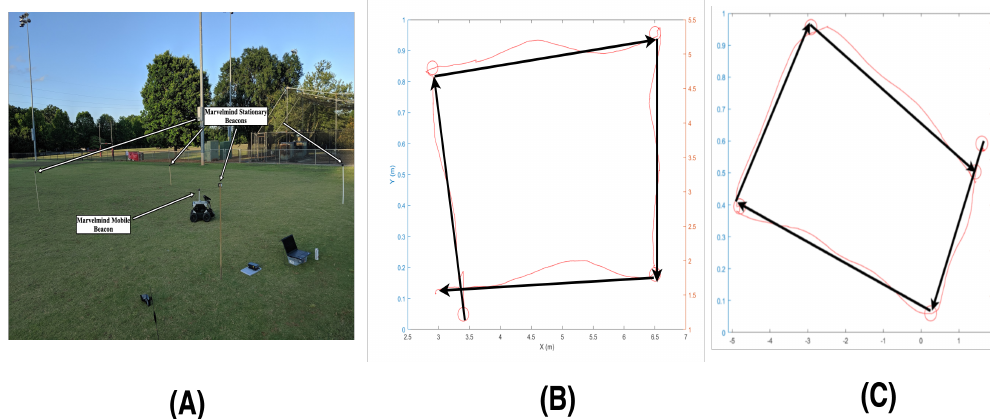
Figure 12. Navigation results. ( A ) Marvelmind based navigation setup; ( B ) Marvemind beacon navigation result; ( C ) RTK Novatel GPS navigation result. Red lines indicate the real rover trajectory while the black straight lines represent the ideal path.